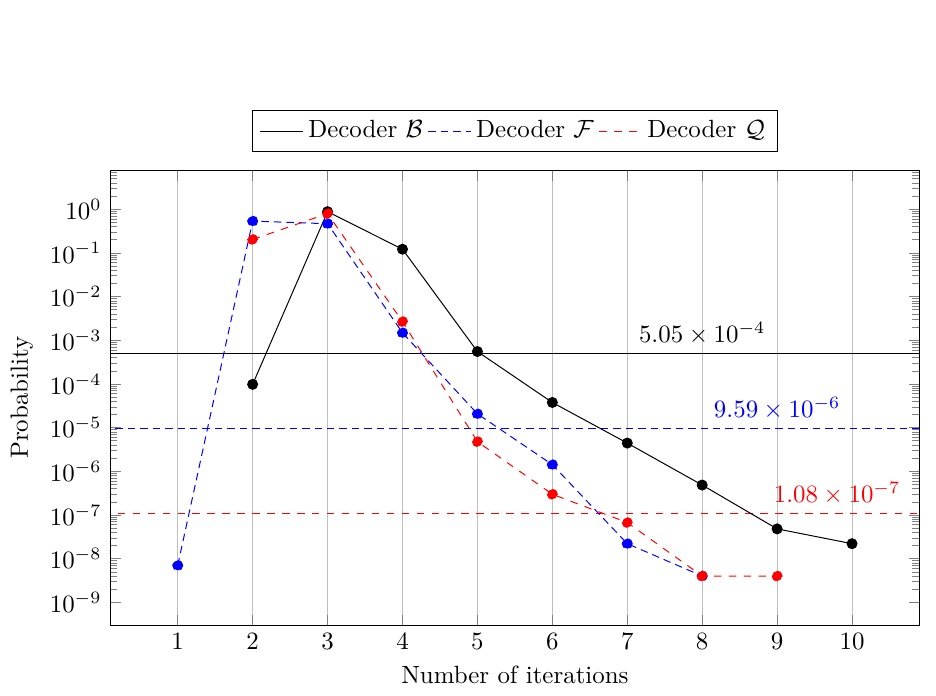
(a) Without error amplification (uniformly random error patterns). This data is based on 2 28 number of decoding trials each, for decoders B , F and Q .